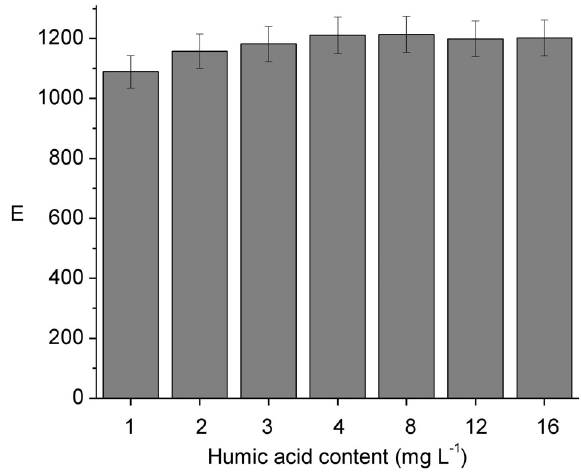
Figure 3. Influence of DOM in the form of humic acids at variable concentrations on the enrichment factor. Donor phase: 6.2 × 10 − 6 mol L − 1 Ni(II), 0.01 mol L − 1 MES, pH 6.6; acceptor phase: 0.01 mol L − 1 HCOOH, pH = 2; membrane phase: 0.012 mol L − 1 Kelex 100; 300 min of sampling